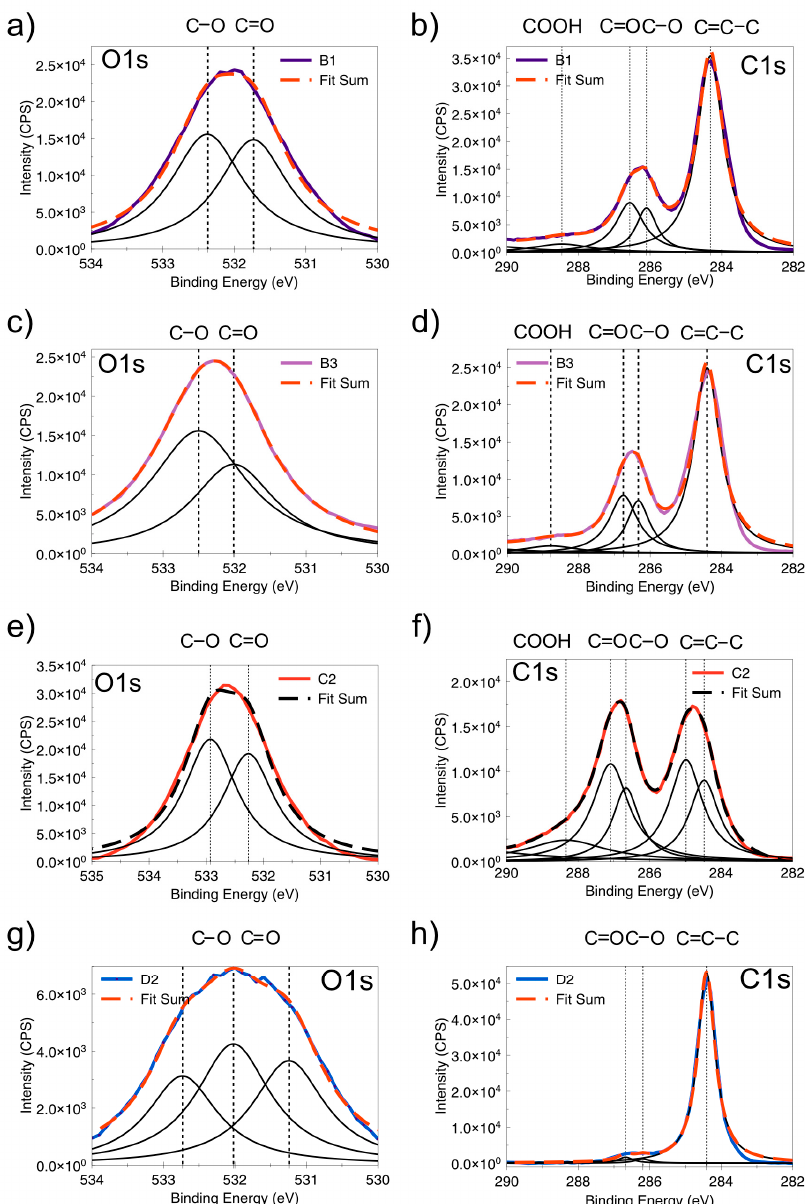
Figure 4. Deconvolution of the C1s and O1s peaks. ( a , b ) B1, ( c , d ) B3, ( e , f ) C2, and ( g , h ) D2.